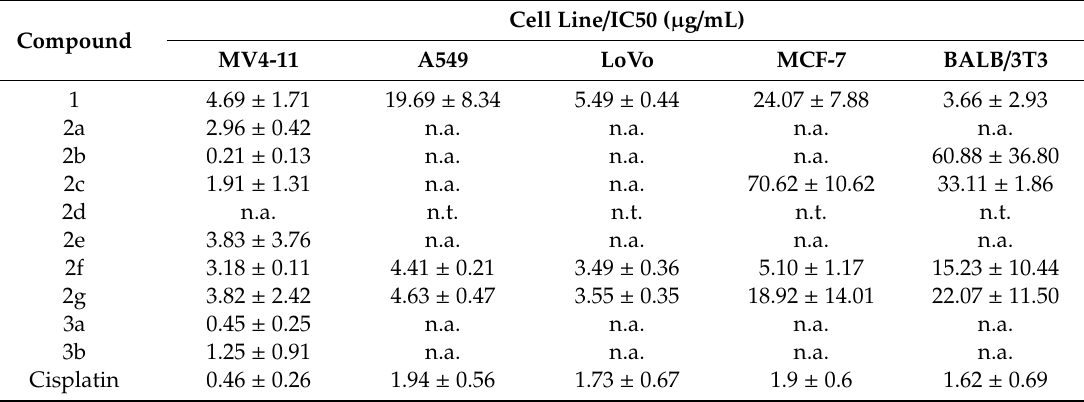
Table 3. Antiproliferative activity of aminophosphonates and phosphine oxides towards the MV4-11 leukemia cell